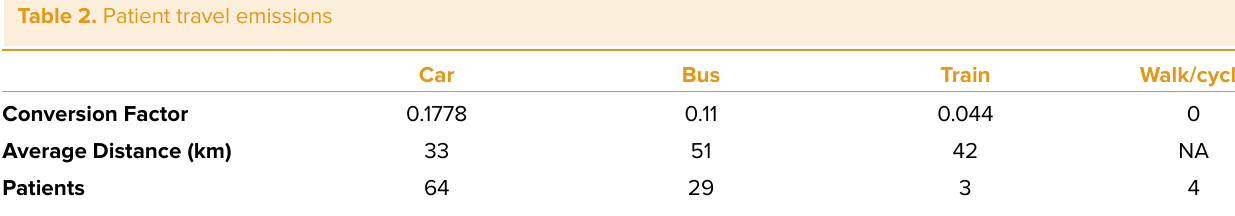
Table 2. Patient travel